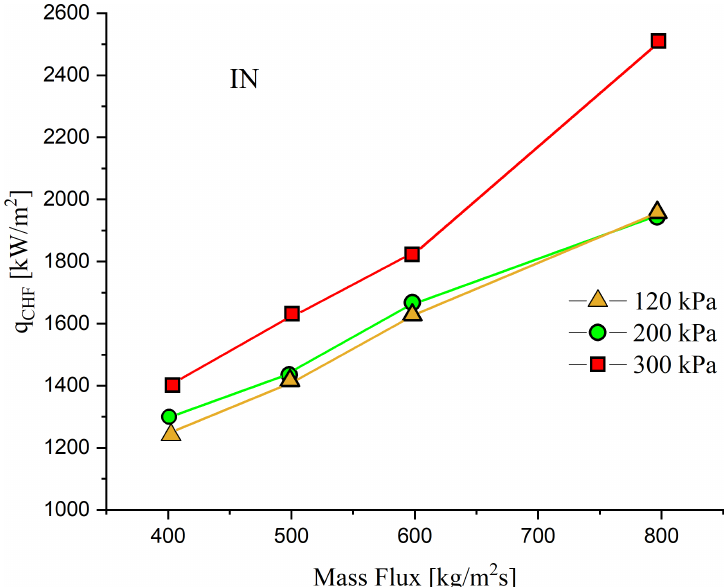
Figure 12. CHF measurements as a function of mass flux at different outlet pressures and inlet subcooling on smooth Inconel tube.